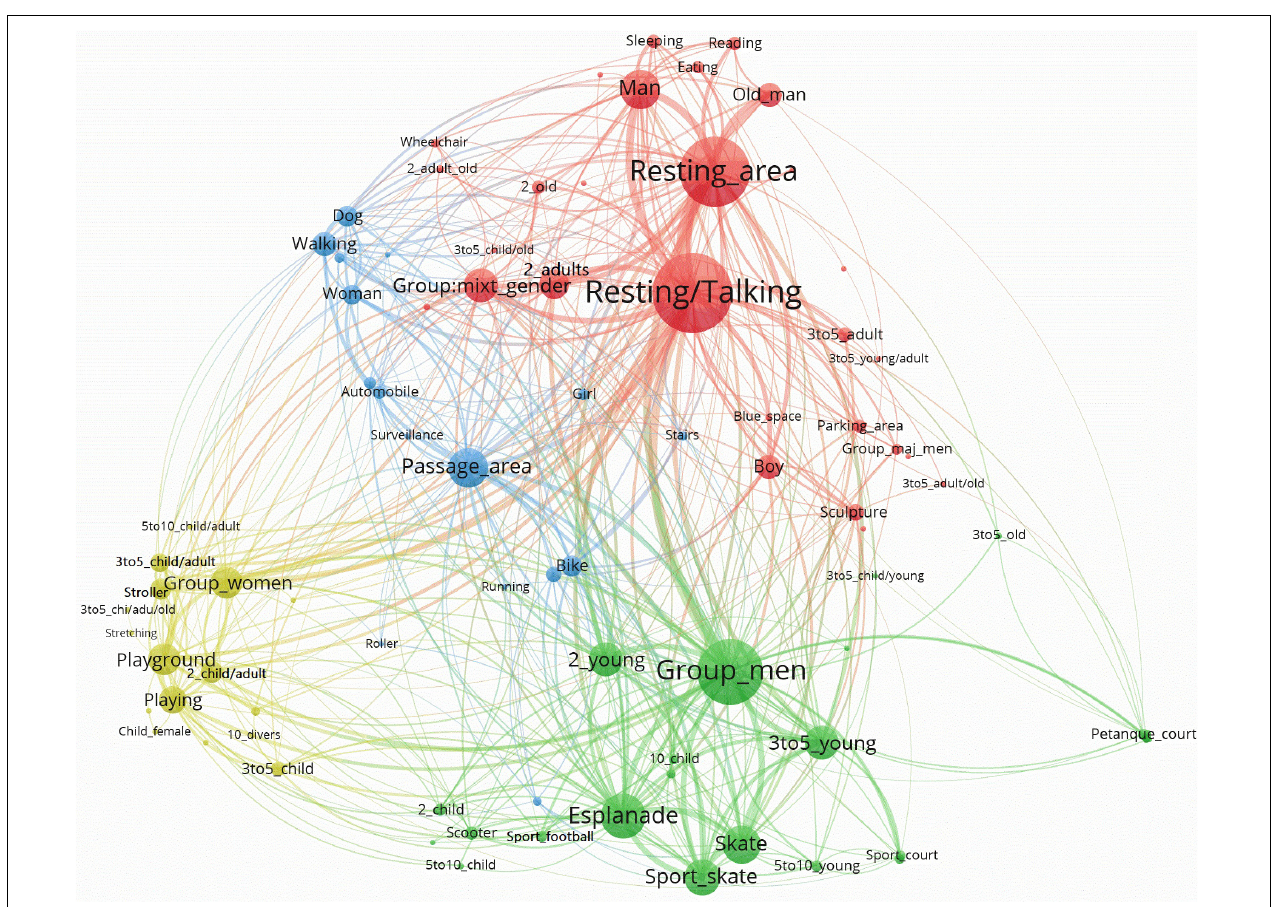
FIGURE 6 | Three Chimneys Park’s network by